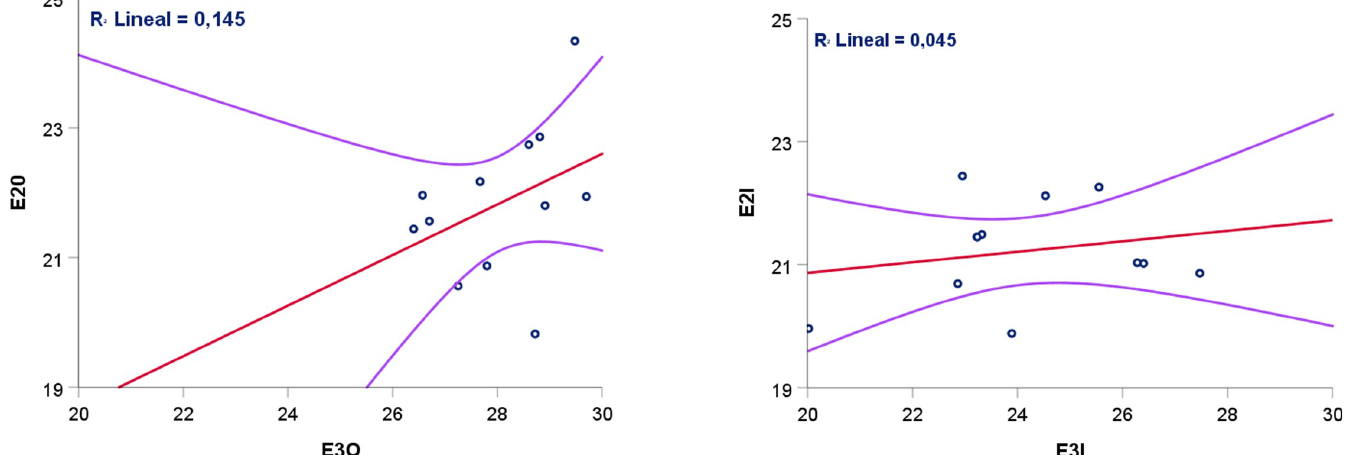
Fig 6. Scatterplot of the correlation between E 2 and E 3 for (A) outer and (B) inner parietal cortical plates.